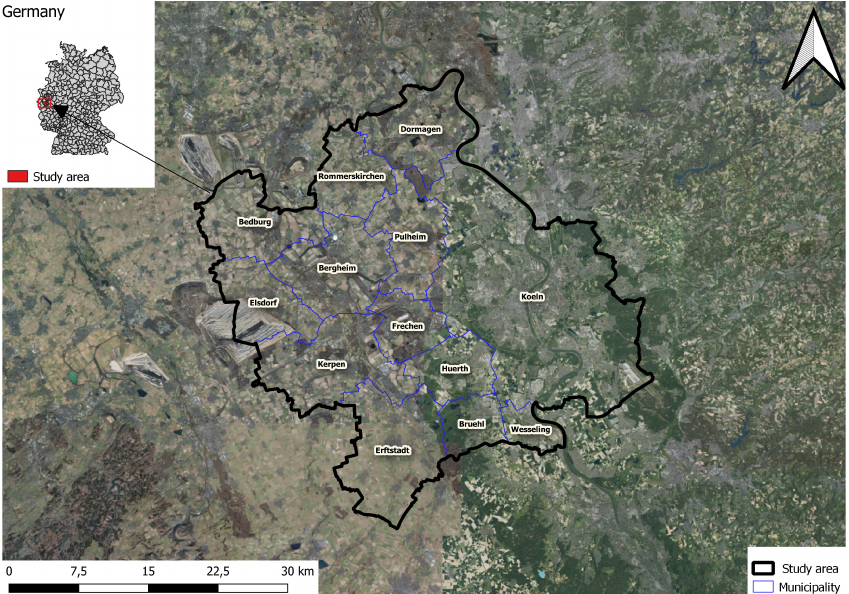
Figure 1. The study area is located in western Germany, covering several municipalities and the city of cologne which are labeled for reference. Large parts of the area are used for agriculture. Also visible at the satellite image is the ongoing open pit mining in the western part of the area.